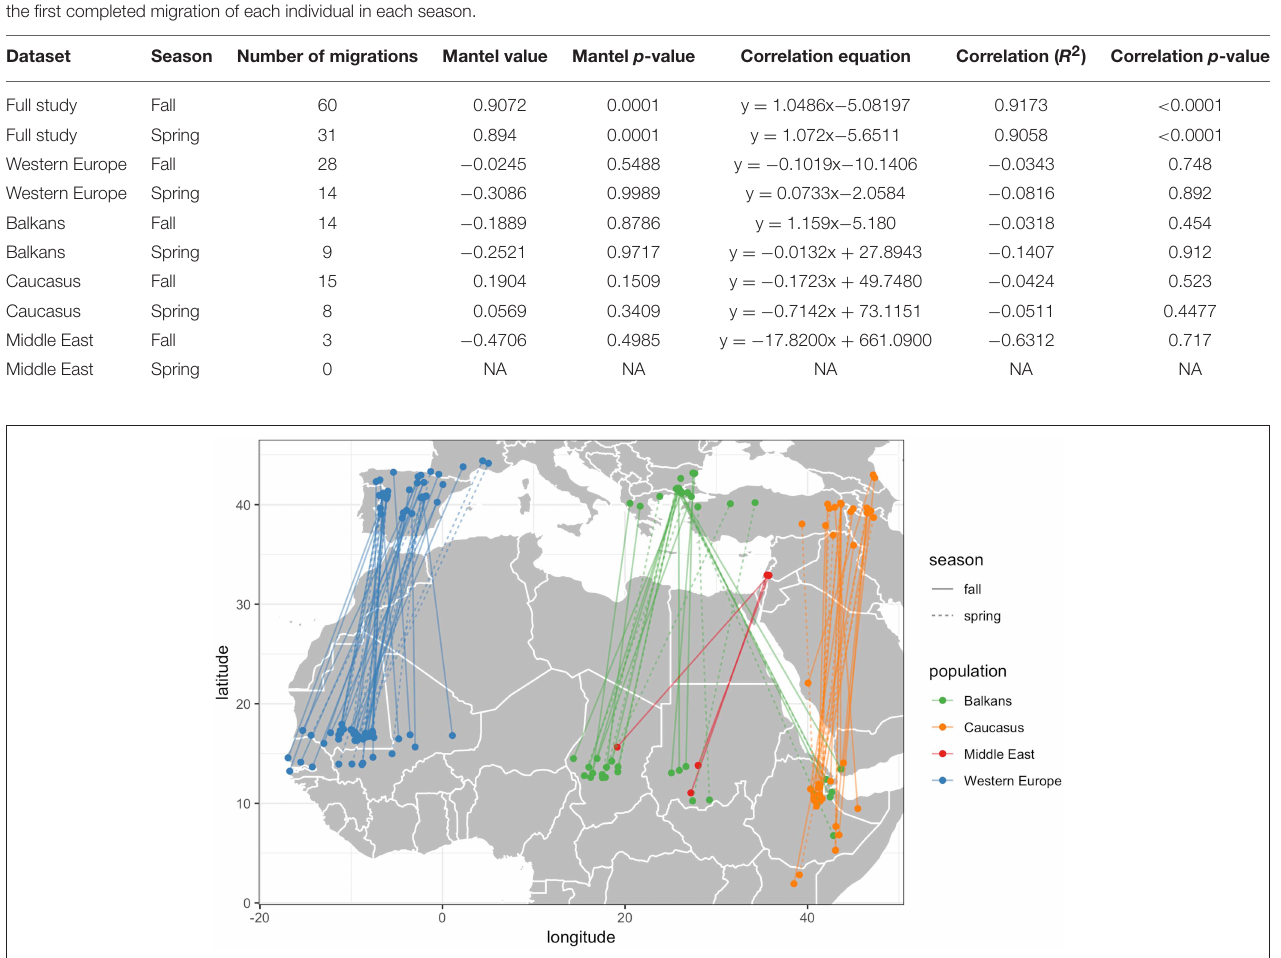
FIGURE 2 | Start and end locations of the first complete spring and fall migrations of 60 individual Egyptian Vultures used to assess migratory connectivity within and among four